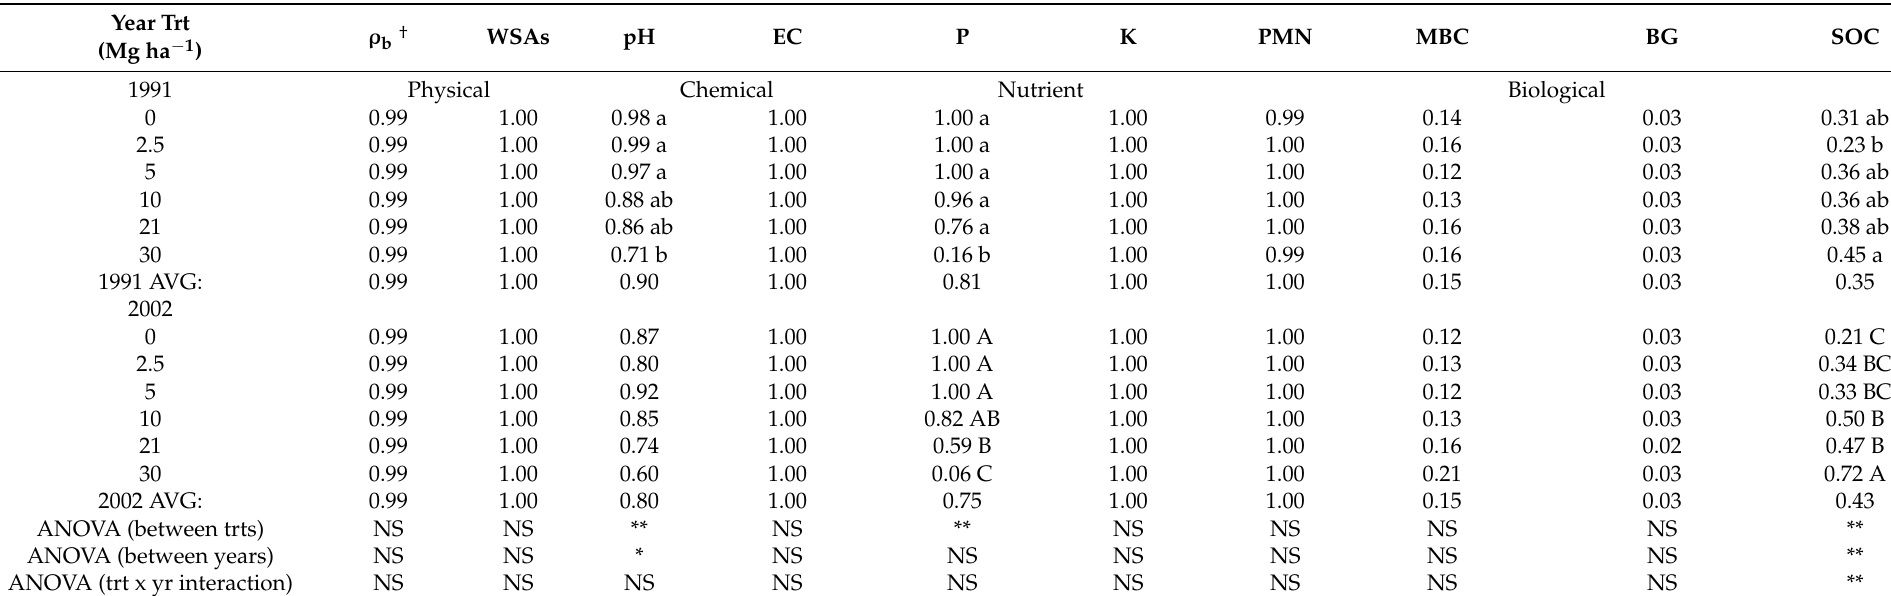
Table 3. Mean soil indicator scores (0.00 to 1.00; greater is “better”; determined by the SMAF) from soil collected from the 0–15 cm depth (collected in 2018), as affected by increasing single (applied in 1991) or repeated (applied in 2002) biosolids applications to a degraded rangeland at the Fort Collins, Colorado, USA Meadow Springs Ranch. When present, different letters between treatments within a given application year represent significant differences at the p < 0.05